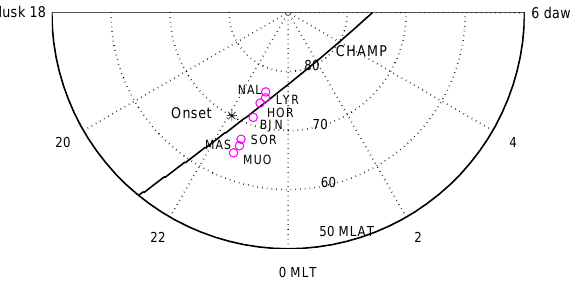
Fig. 1. CHAMP track in the ionosphere (line), conjugate substorm onset region (asterisk) and location of considered IMAGE magne- tometer stations (circle) at onset time, 20:14 UT.